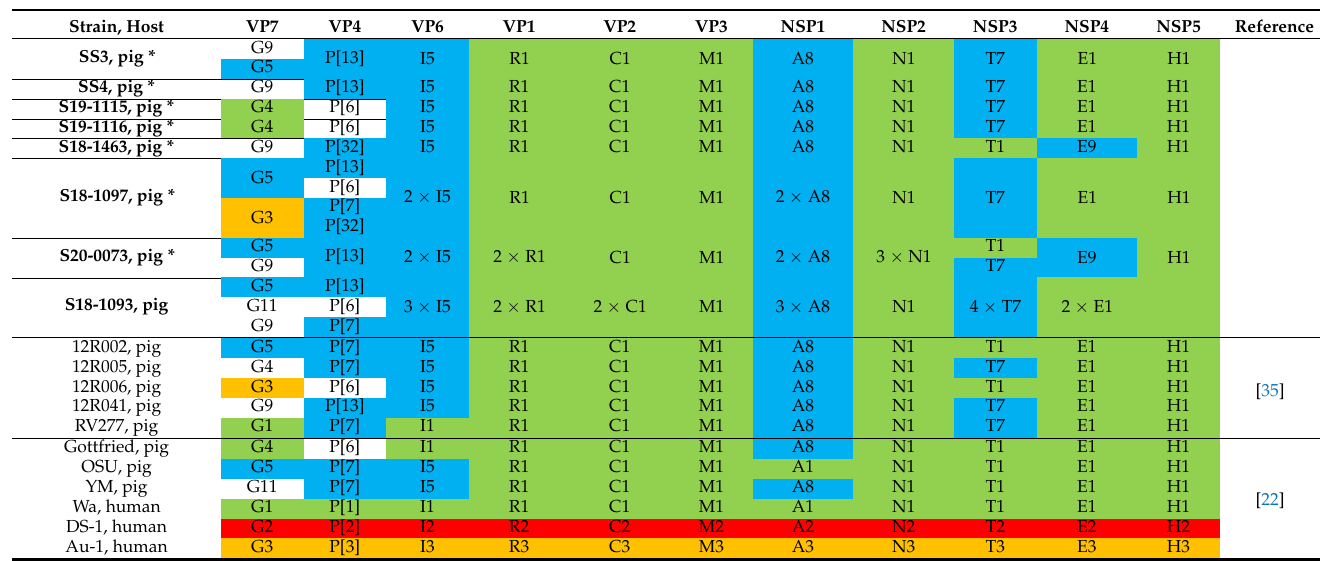
Table 1. RVA genotypes of strains from this study (bold) and reference strains. Wa-like genotypes are colored green, SD-1-like red, Au-1-like orange, typical porcine genotypes blue, and mixed or unclear genotypes are